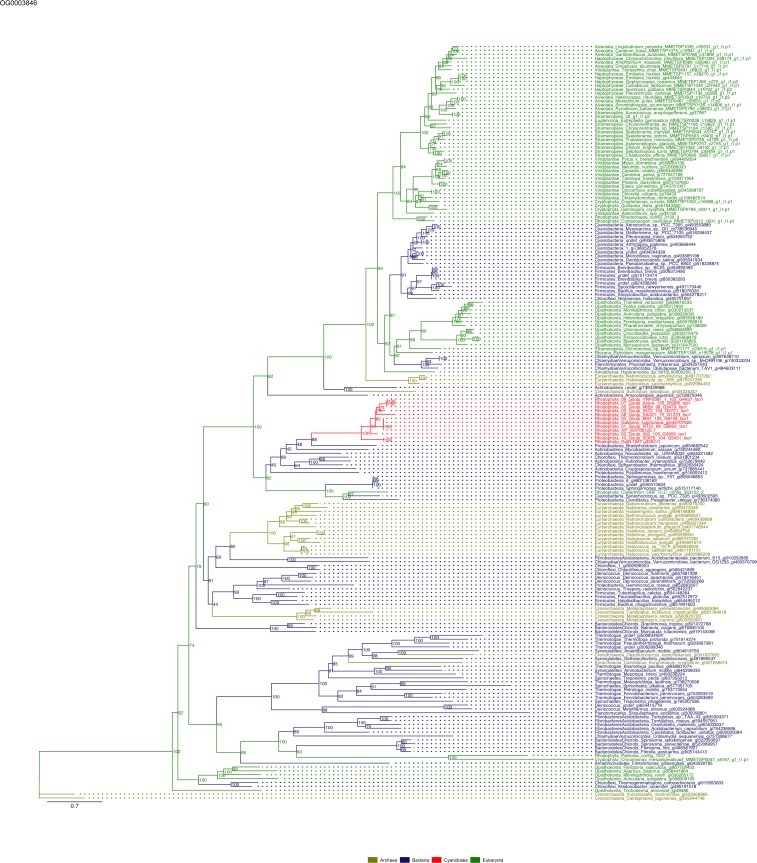
Sequence tree of orthogroup OG0003846.The tree is based on amino acid sequences. Archaea (yellow), Bacteria (blue), Cyanidiales (red), Eukaryotes including other red algae (green). Branches containing Cyanidiales sequences are highlited in red.